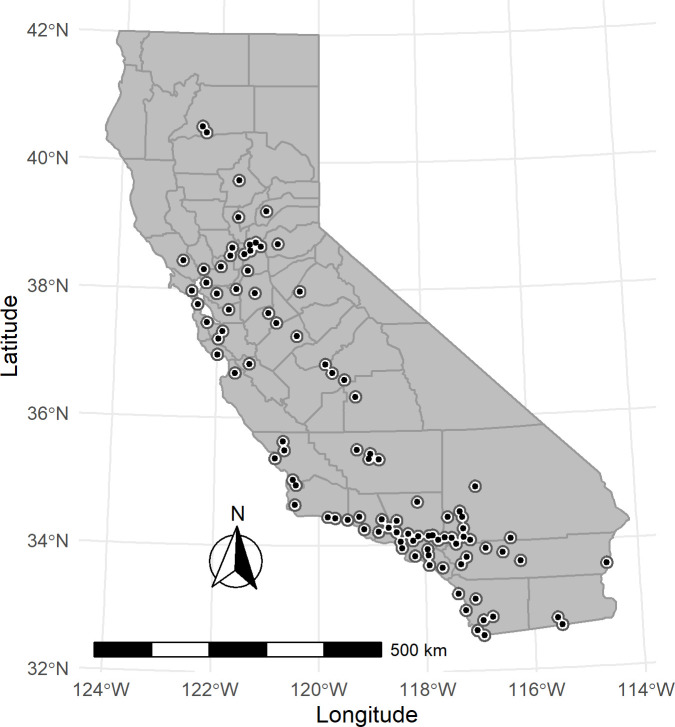
Map of study O3 air monitors (with 10-kilometer buffer) in California (N = 91).